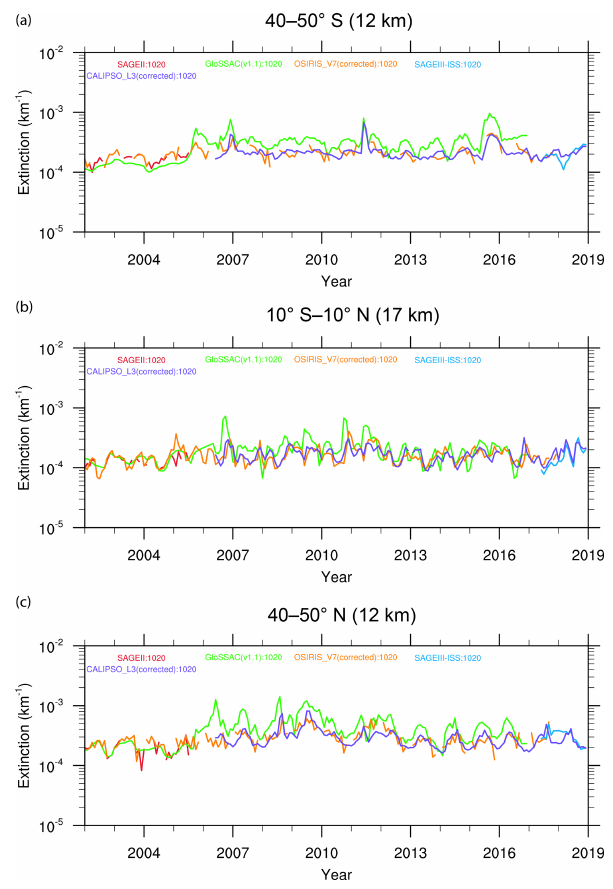
Figure 12. Zonally averaged monthly time series plots of the ex- tinction coefficient at 1020nm for different latitude bands and alti-